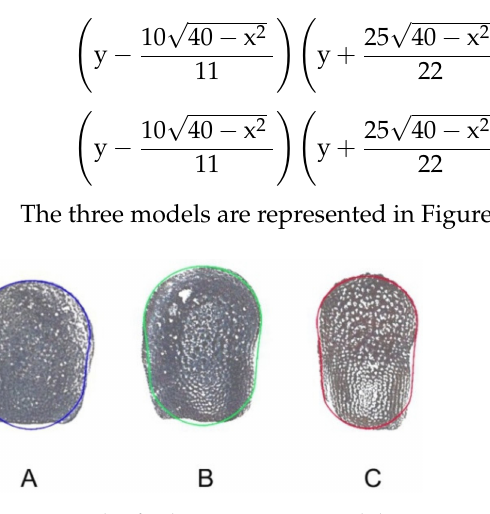
Figure 2. Seeds of Echinopsis species and their corresponding models. ( A ) E. calochlora ; ( B ) E. leucantha ; ( C ) E. klingeriana